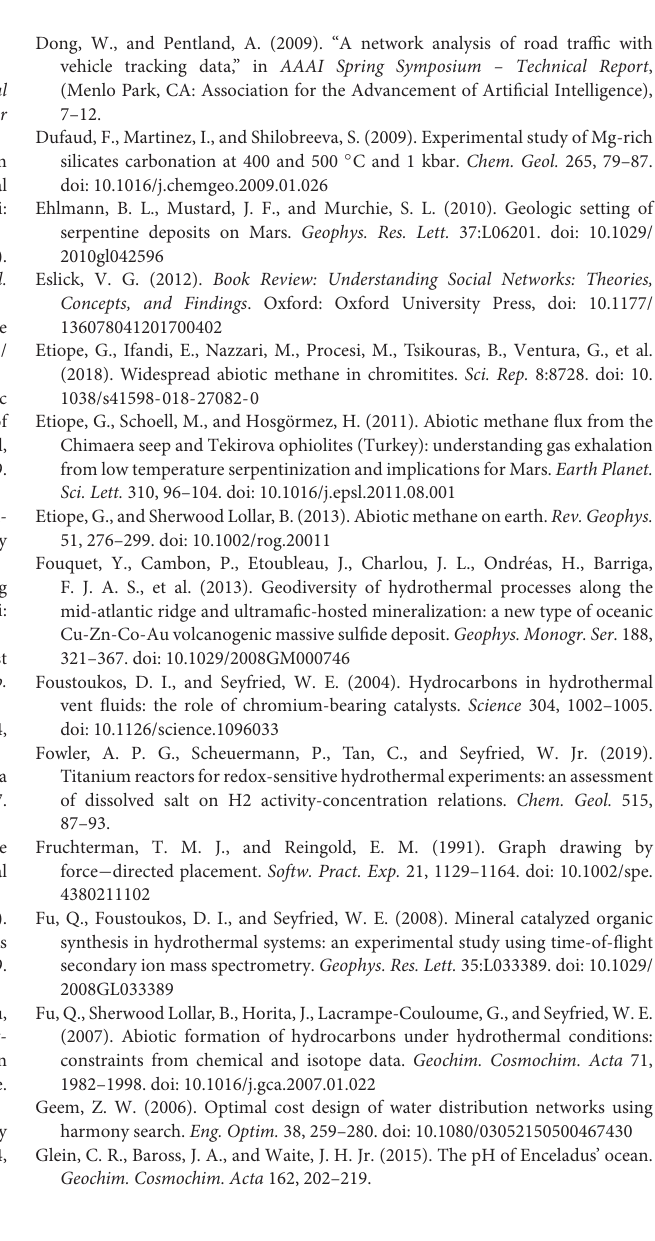
removing the weakest 10, 30, 50, and 70 % of the edge connections. Results show that the number of communities detected is always four, and communities 0, 1, and 3 almost stayed the same. The algorithm is pretty robust. Therefore, we did the analysis by removing 70% of the weakest edges. FIGURE S3 | (A) Full networks representation of experiments with or without solid reactants—white means with solids and yellow means fluid only. Experiments with or without a specific solid reactant—white means without and yellow means with: (B) sodium bicarbonate; (C) NaCl; (D) other salts, including KCl, 2 O. FIGURE S4 | In addition to Figure 7 , it shows the distribution of the concentration of (A) H 2 , (B) CH 4 , (C) total other organics in mM, and (D) carbon ratio, across the experiments represented in individual community networks. Color coding consistent with Figure 7